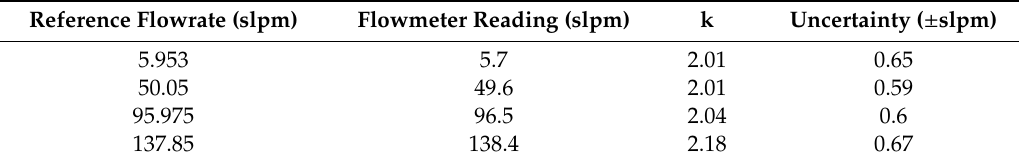
Table 6. Automated flowmeter calibration sheet at sea level pressure.